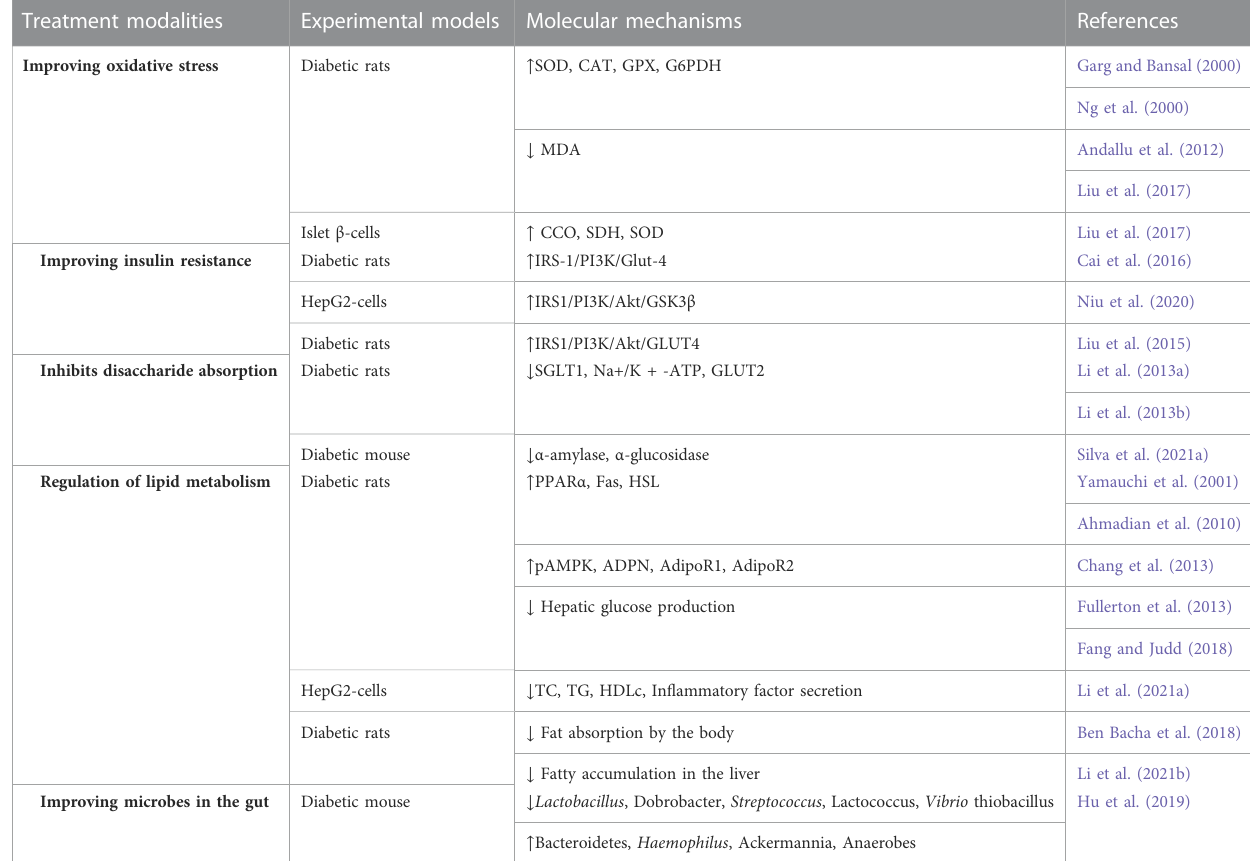
TABLE 2 Molecular mechanisms of mulberry leaves in the treatment of diabetes